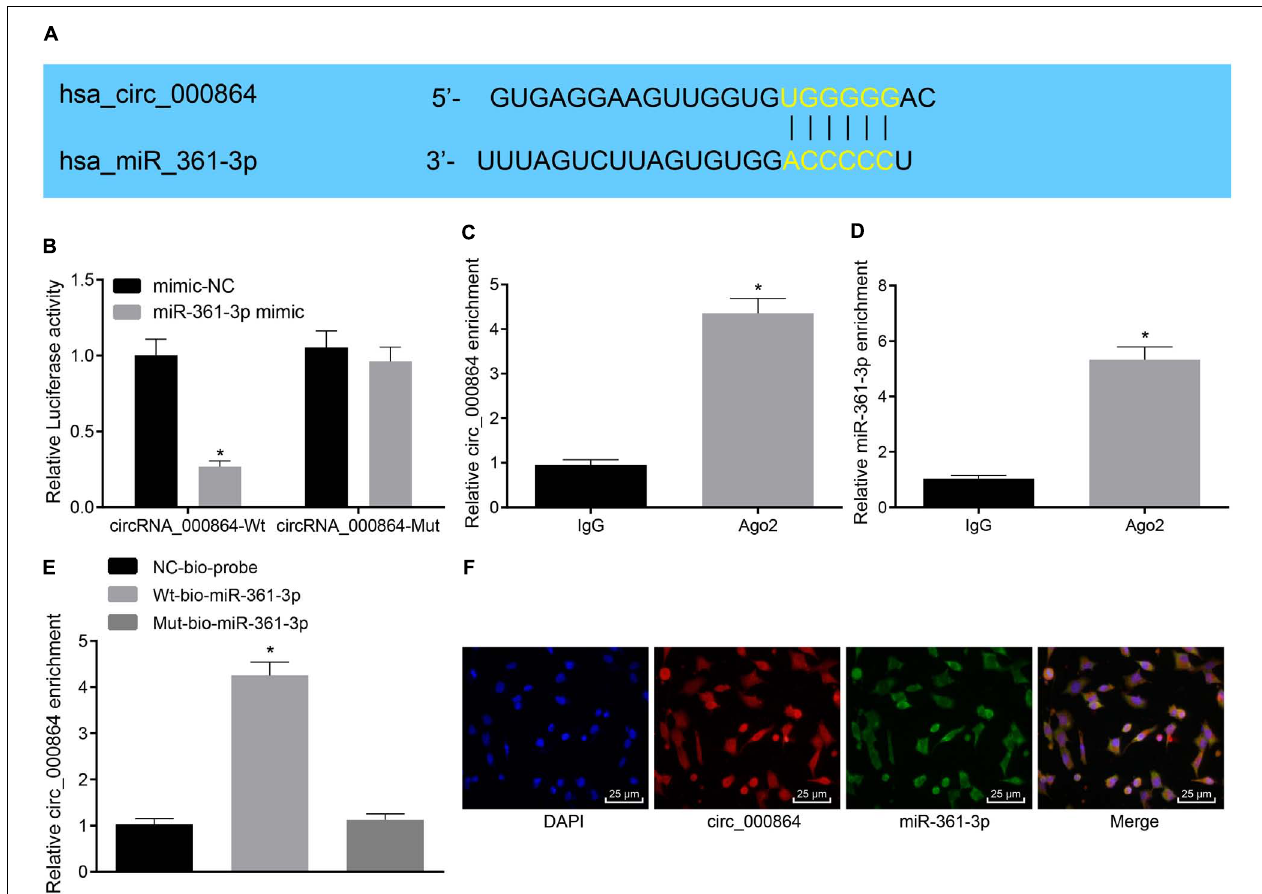
FIGURE 4 | MiR-361-3p combines with circRNA_000864. (A) The binding site between circRNA_000864 and miR-361-3p predicted by biology websites. (B) The binding relationship between circRNA_000864 and miR-361-3p verified by dual-luciferase reporter gene assay. (C) The binding between circRNA_000864 and Argonaute 2 (Ago2) detected by RNA Immunoprecipitation (RIP) assay. (D) The binding between miR-361-3p and Ago2 determined by RIP assay. (E) The binding between circRNA_000864 and miR-361-3p measured by RNA-pull down assay. (F) Colocalization of circRNA_000864 with miR-361-3p in the cytoplasm evaluated by fluorescence in situ hybridization (FISH) assay ( × 400). * p < 0.05 vs. AsPC-1 cells transfected with mimic-NC or IgG or Mut-miR-361-3p. The above data were all measurement data, and the statistical results are expressed as sample mean ± standard deviation. (E) Data were compared by one-way ANOVA (Dunnett’s post hoc test), and data of the remaining figures were analyzed using the unpaired t -test. The experiment was conducted three times